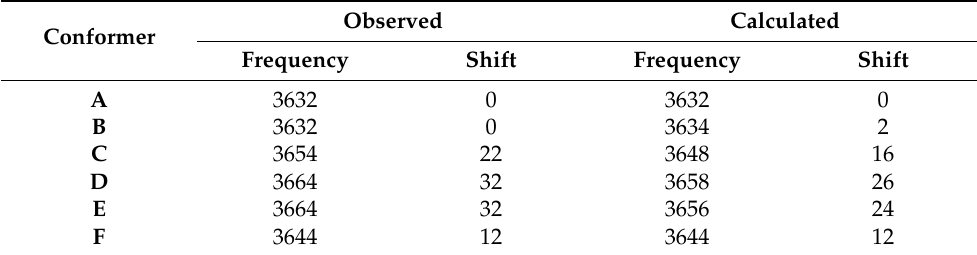
Figure 4. Observed vapor-phase infrared of 2CPOL for the O-H stretch region. Table 4. O-H stretching frequencies (cm − 1 ) for the six conformers of